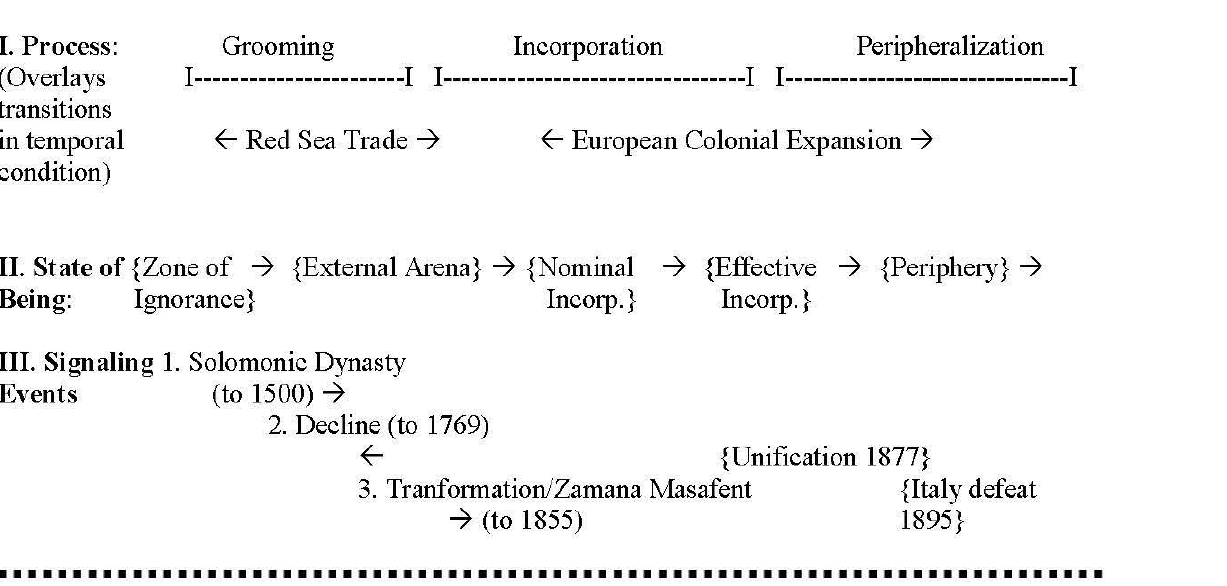
Figure 7: Abyssinian Incorporation. Typography of Abyssinian Incorporation,